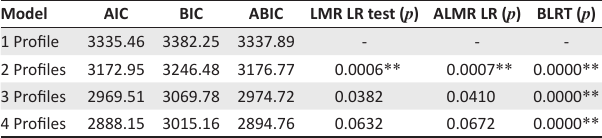
TABLE 5 : Comparison of different latent profile